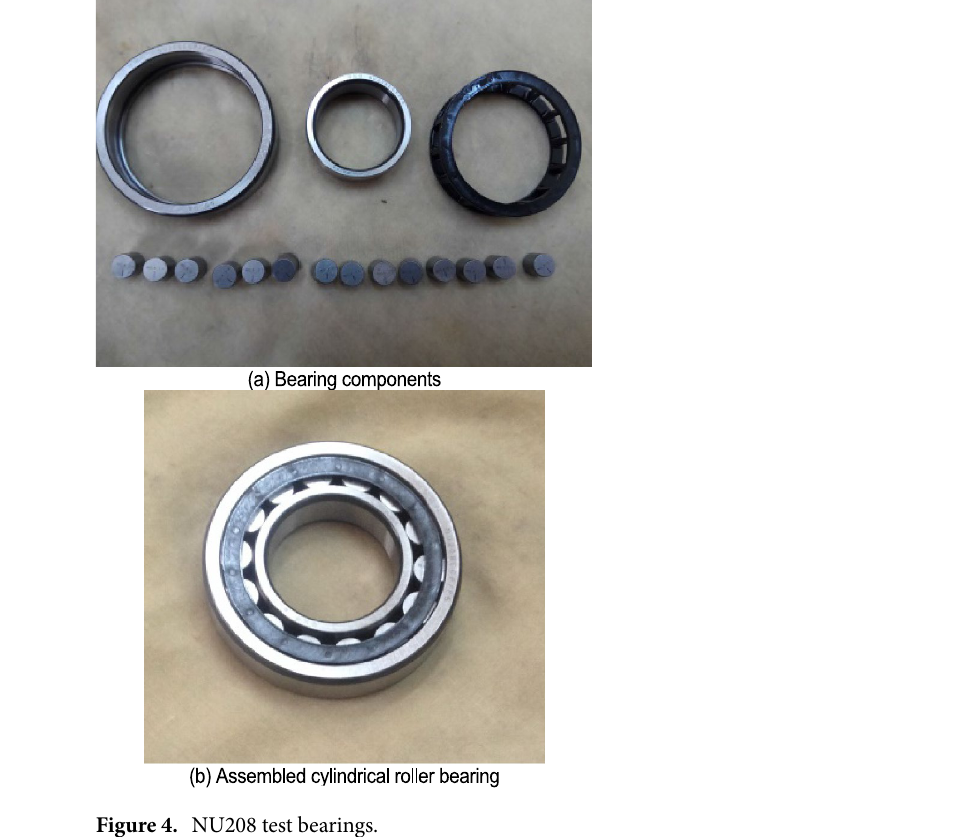
Figure 4. NU208 test bearings.